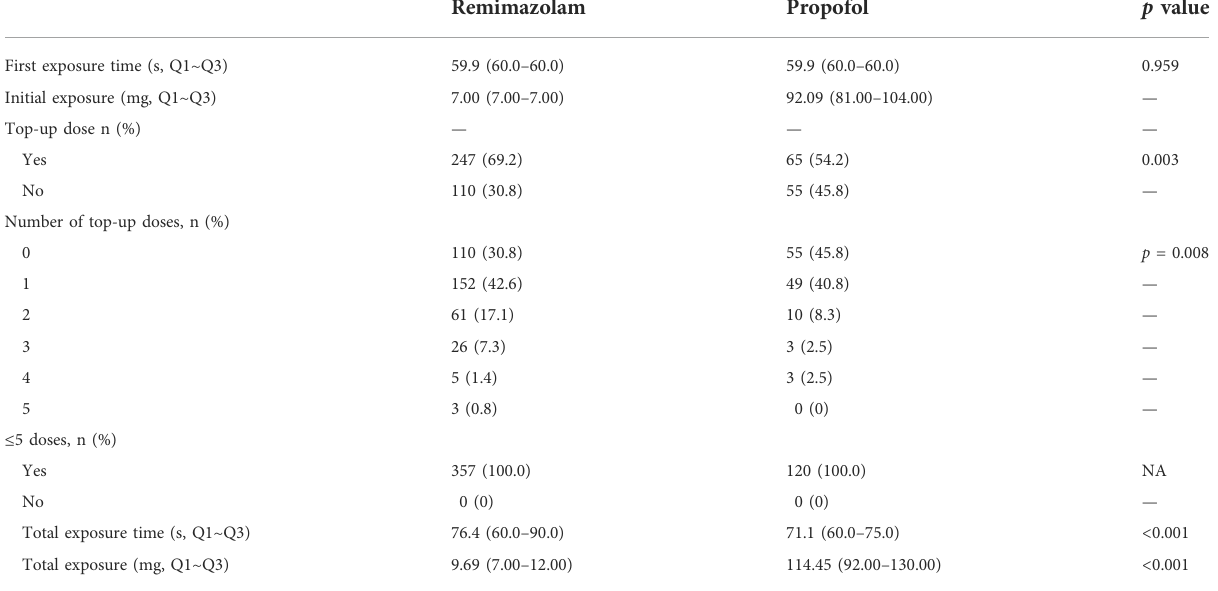
TABLE 3 Study drug exposure.